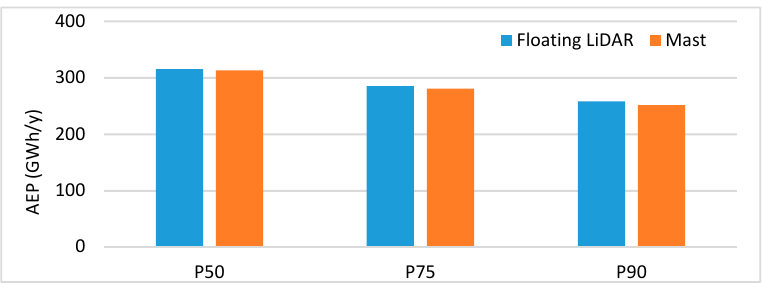
Figure 11. AEP of P 50 , P 75 , and P 90 was estimated for 10 years by using data from the floating LiDAR device and mast.